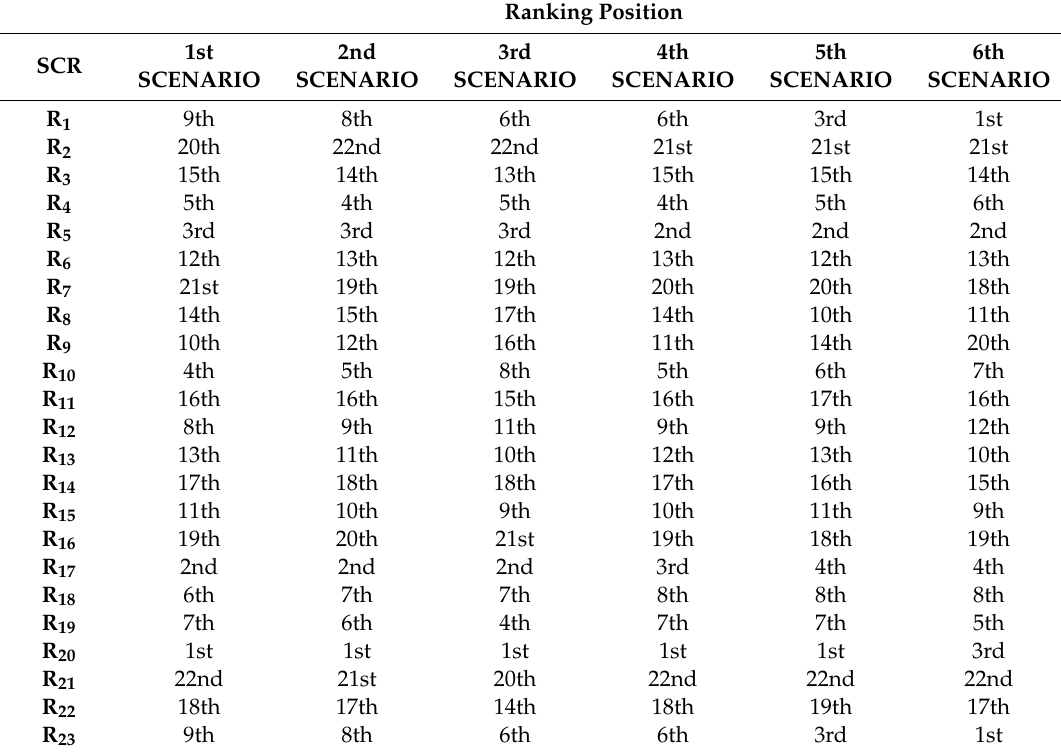
Table 13. Sensitivity analysis varying the weights of